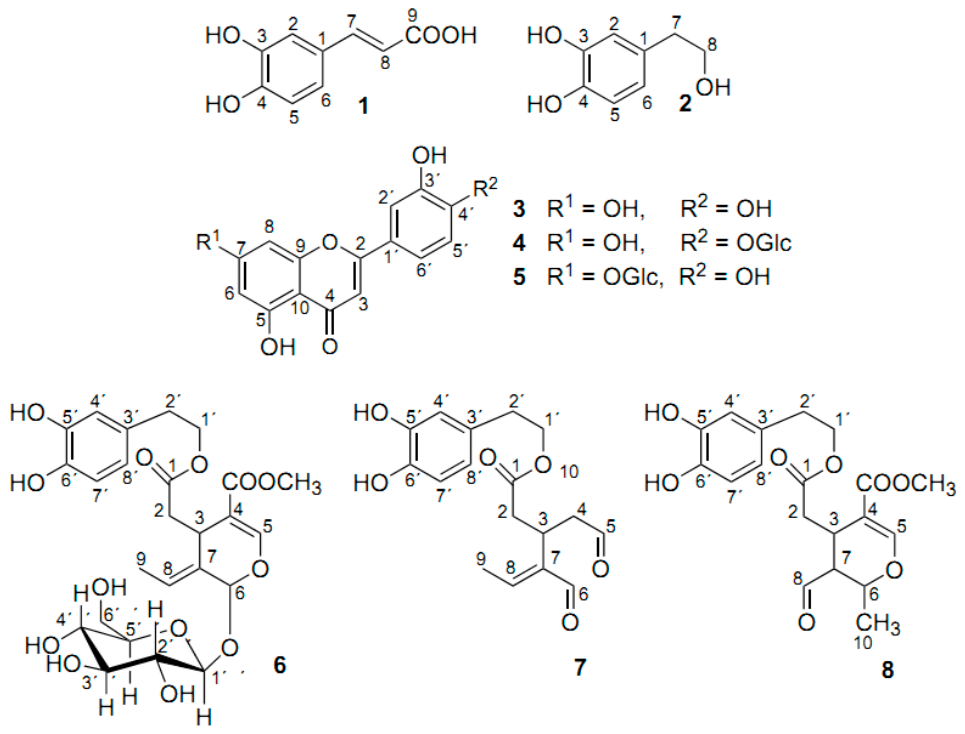
Figure 24. Chemical structures of the compounds which were identified in olive leaf methanol and aqueous extracts [16].